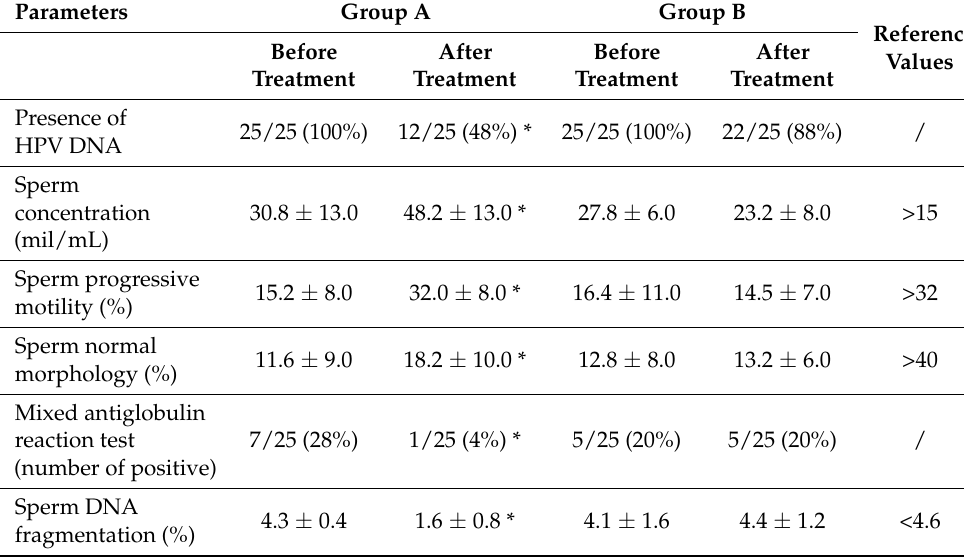
Table 1. Sperm parameters and prevalence of HPV DNA in the semen fluid of patients before and after 3 months of either treatment with ellagic acid (100 mg) and Annona muricata (100 mg) (Group A), or observation only (Group